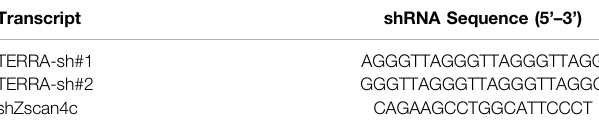
TABLE 1 | List of shRNA speci fi c sequences used for target gene knockdown. Transcript